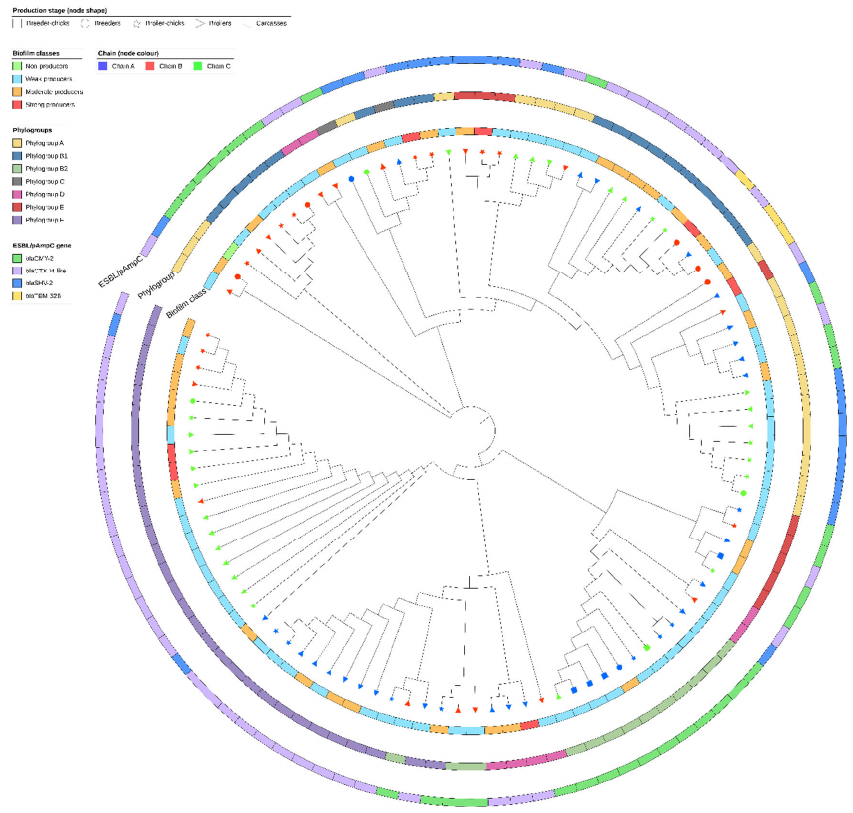
Figure 4. Hierarchical clustering analyses based on average linkage distance and Euclidean distance measurement methods showing the clustering pattern of ESBL/pAmpC-EC strains ( n = 102) and variable virulence genes ( n = 21). Nodes shape and color indicate the broiler production stage and production chain, respectively. The inner stripe indicates the biofilm classes. The middle stripe indicates the phylogroups. The outer ring specifies the ESBL/pAmpC genes identified.